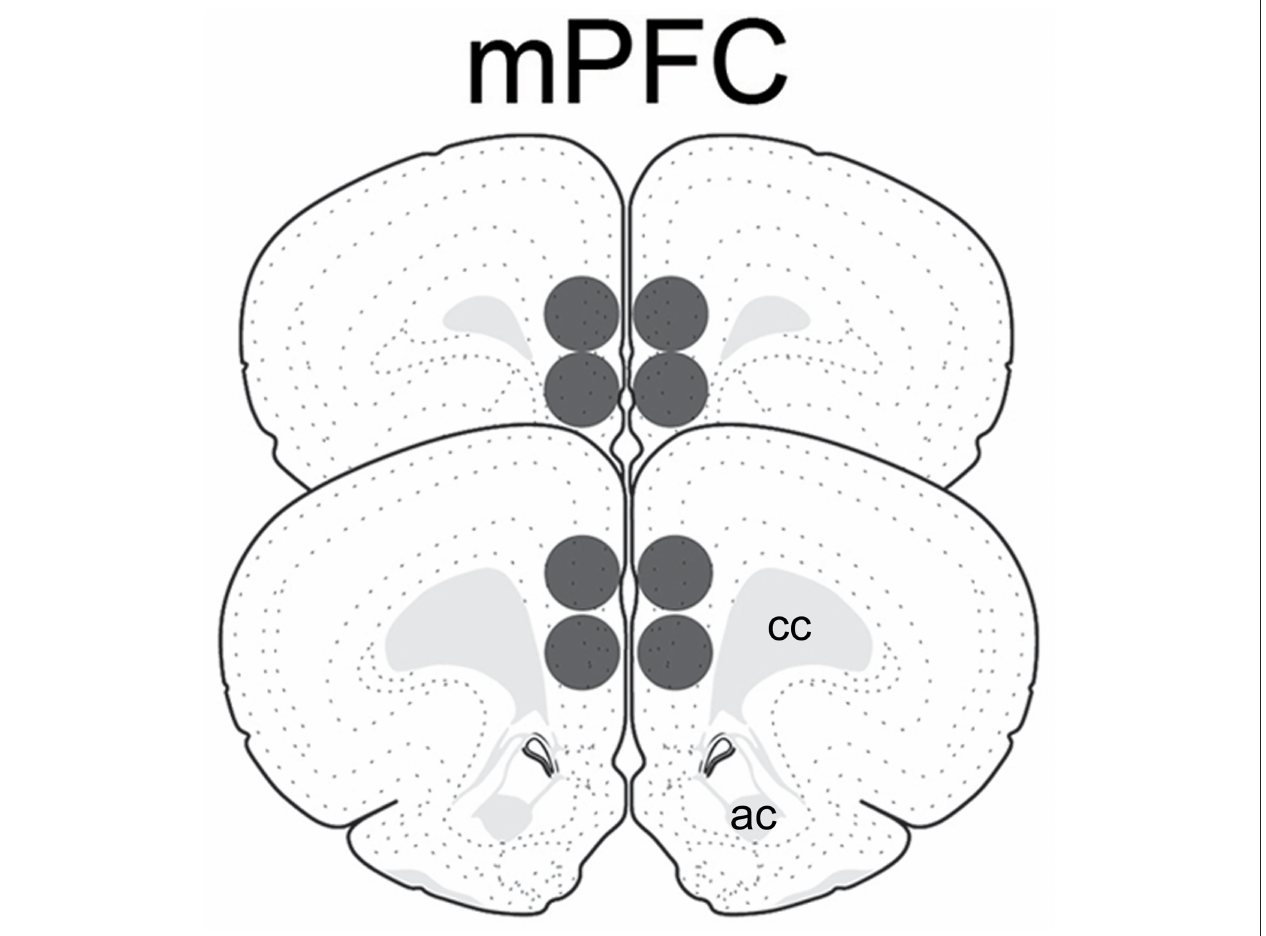
FIGURE 1 | Schematic representation of tissue punches within the medial prefrontal cortex analyzed for GAD 65 and vGAT. Images modified from Swanson (47). ac, anterior commissure; cc, corpus callosum.